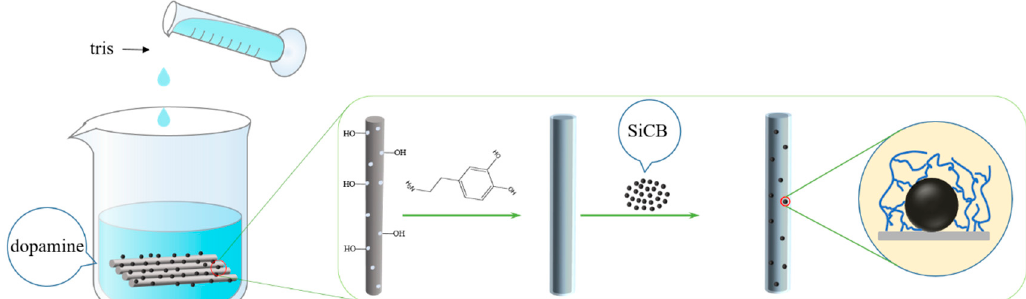
Figure 4. Flow chart of SiCB + PDA synergistic modification of BF.